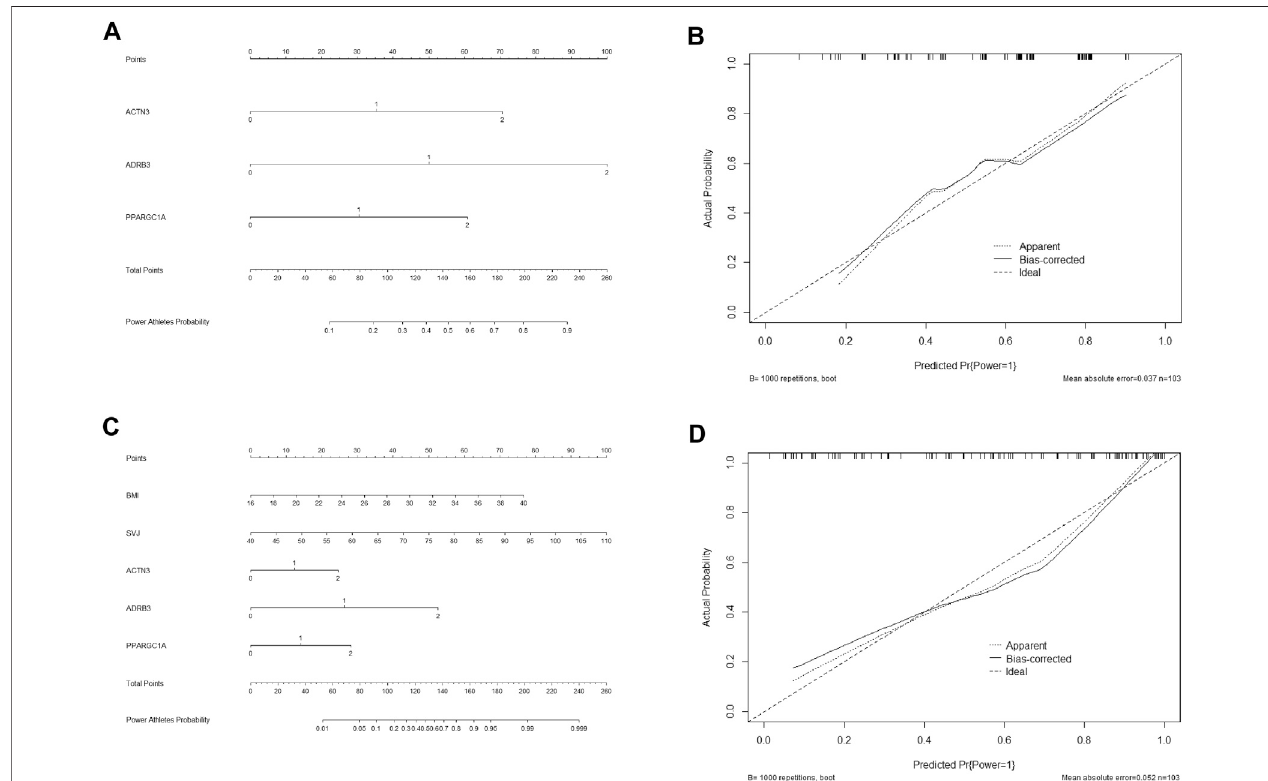
FIGURE 4 | Nomograms of predictive and identifying models for elite power performance and their calibration curves. Genotype value of three SNPs in nomograms: ACTN3, RR (cid:1) 2 RX (cid:1) 1 XX (cid:1) 0; ADRB3, TT (cid:1) 2 TC (cid:1) 1 CC (cid:1) 0; PPARGC1A, AA (cid:1) 2 AG (cid:1) 1 GG (cid:1) 0. (A) Nomogram of predictive model (model1 only includingthreeSNPs)forelitepowerperformance. (B) Calibrationcurveofpredictivemodel. (C) Nomogramofidentifyingmodel(model5includingthreeSNPs,BMIand SVJ) for elite power performance. (D) Calibration curve of identifying model.